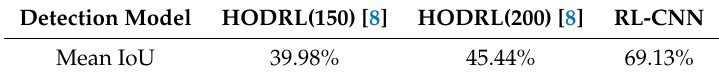
Table 3. Mean Intersection-over-Union (IoU) of HODRL [8] and RL-CNN detection models.